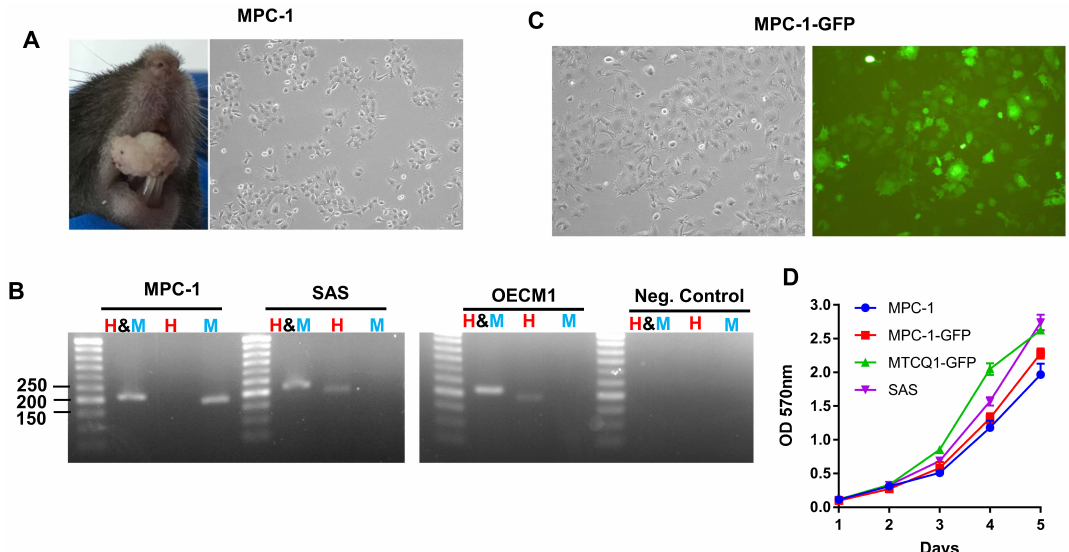
Figure 1. Establishment of the MPC-1 cell line. ( A ) Left, an exophytic tumor growing on the palate of a C57BL / 7 mouse. Right, the morphology of the established MPC-1 cell line. Magnification: × 100. ( B ) Genotyping of MPC-1, SAS, and OECM1 cells using PCR to amplify the PTGER2 gene. The di ff erential amplification and sizes of the PCR products generated by di ff erent inputs and primers confirms the mouse origin of the MPC-1 cell line. H & M, both human and mouse; H, human; M, mouse. ( C ) Left, the morphology of the MPC-1-GFP cell subclone. Right, the fluorescence image of MPC-1 cells. Magnification: × 250. ( D ) The growth curves of the MPC-1, MPC-1-GFP, MTCQ1-GFP, and SAS cell lines. Human SAS and OECM1 cell lines, and murine MTCQ1-GFP OSCC cell subclone are served as controls to assay the origin or the grow potential of MPC-1 and